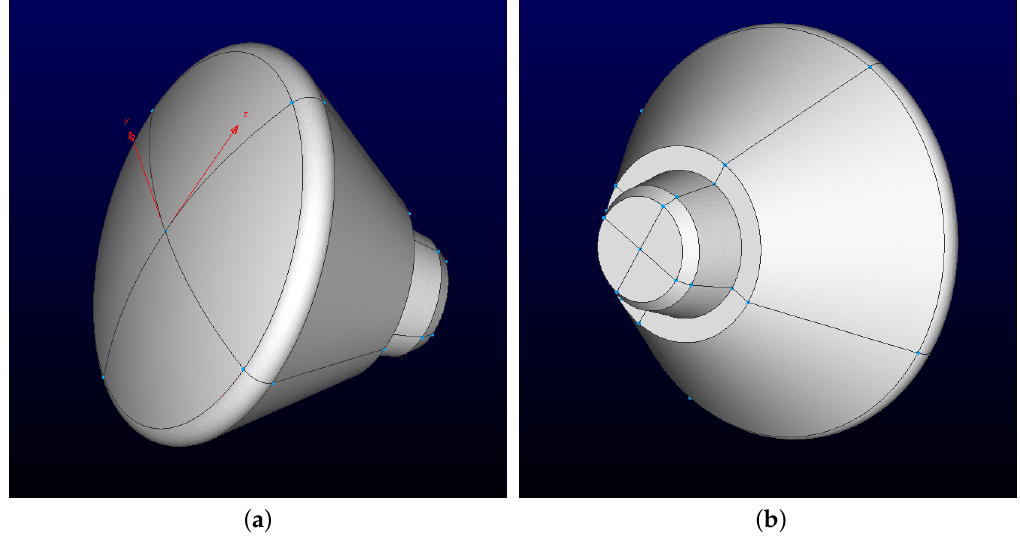
Figure 3. Analysis model of the ESA ARD. ( a ) Front side view; ( b ) rear side